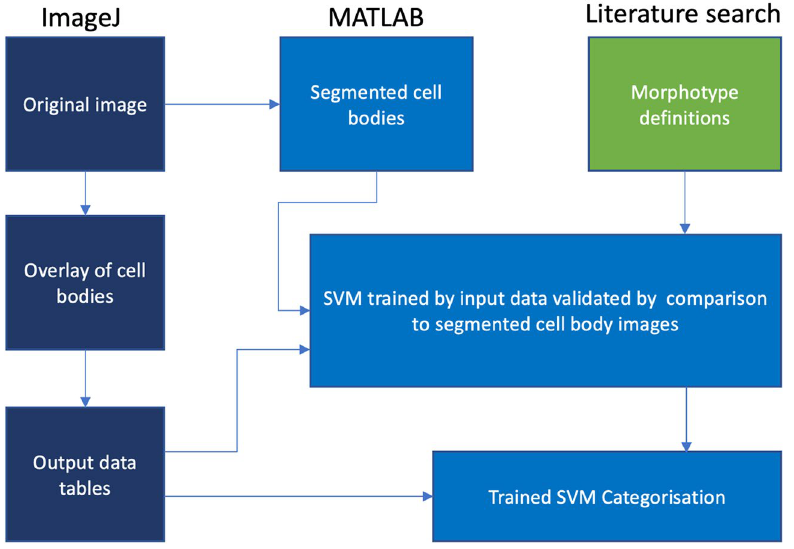
Figure 7. SVM-C Development process. The main processes involved in developing the SVM-C. Dark blue are processes performed using ImageJ, lighter blue using MATLAB, and green using literature